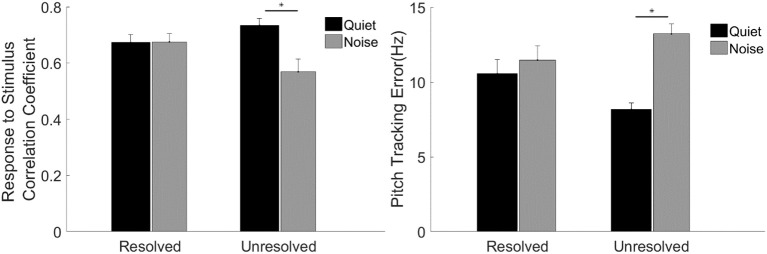
The stimulus-to-response correlation coefficient (left) and F0 curve tracking error (right) averaged across participants for each stimulus condition. The black and gray bars represent the response in quiet and in noise condition, respectively. Error bars represent one standard error of the mean. The significant difference of p < 0.001 is indicated by the asterisk.